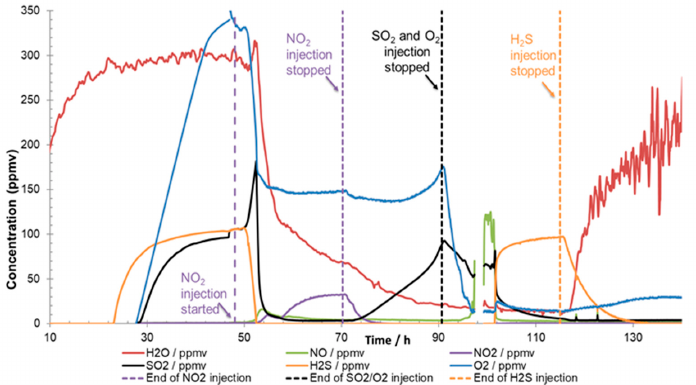
Figure 9. The result of first injecting of 300 ppmv H 2 O, 350 ppmv O 2 , 100 ppmv of SO 2 , and H 2 S until the concentration stabilized in 100 bar CO 2 and 25 °C. After about 50 h, the injection of 100 ppmv NO 2 was started and immediately a reaction between the impurities caused a deviation from the setpoints [9].